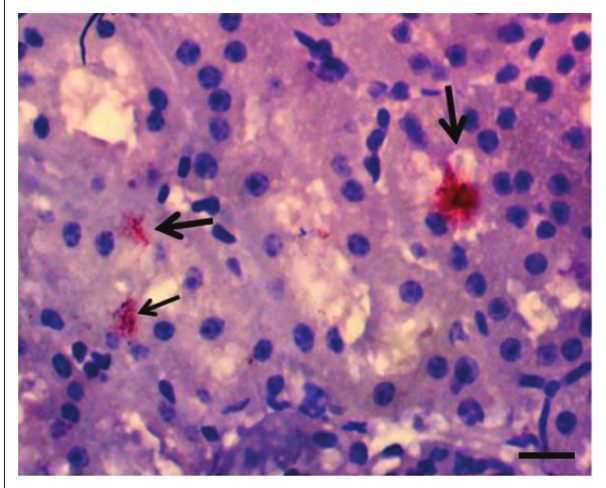
FIGURE 2: Kidney section showing tubular degeneration and necrosis, tubular atrophy with moderate diffuse interstitial lymphoplasmacytic cellular infiltration in antelope positive with Leptospira infection.